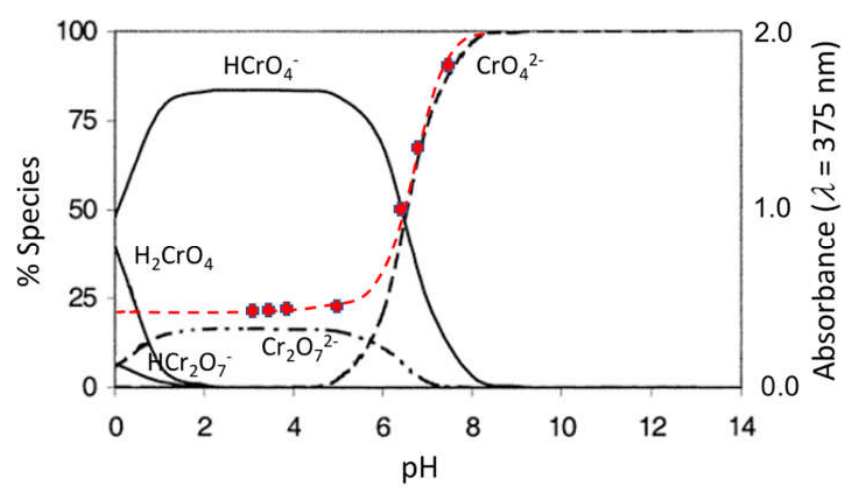
Figure 5. pH-predominance diagram of Cr(VI) species and the measured relationship of the pH dependence of Cr(VI) on its UV–Vis absorbance at 375 nm (red points and line).